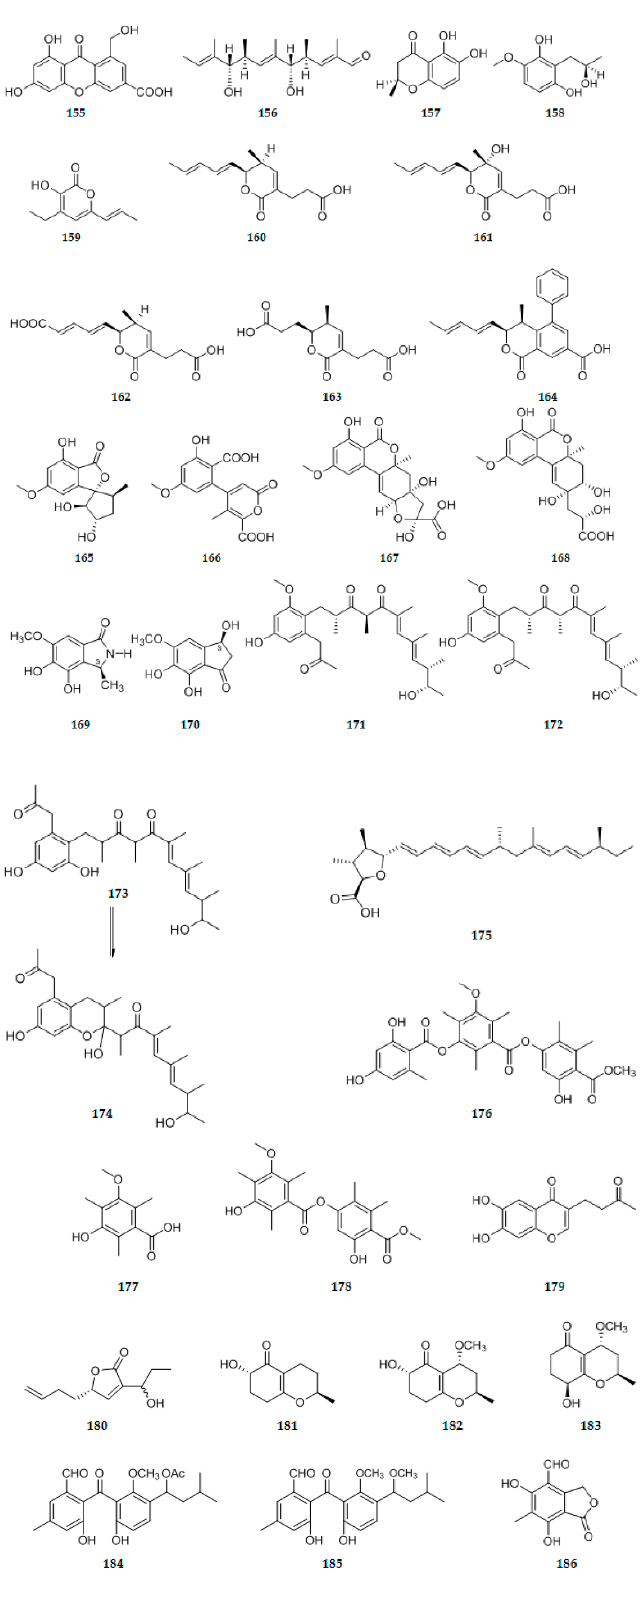
Figure 5. Chemical structures of polyketides.